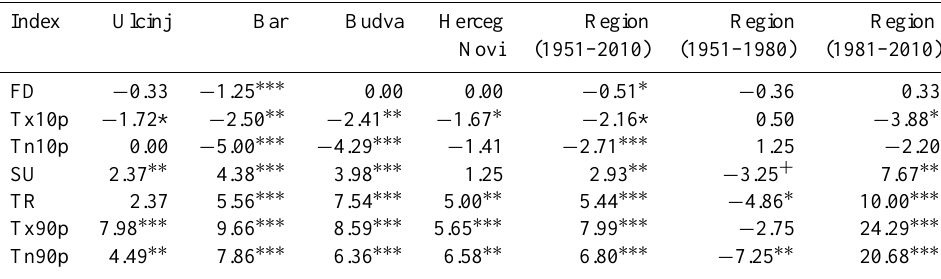
Table 3. Trends in temperature indices in the period 1951–2010 in days per decade (with statistical significance values: ∗∗∗ 0.1% level, ∗∗ 1% level, ∗ 5% level and + 10%